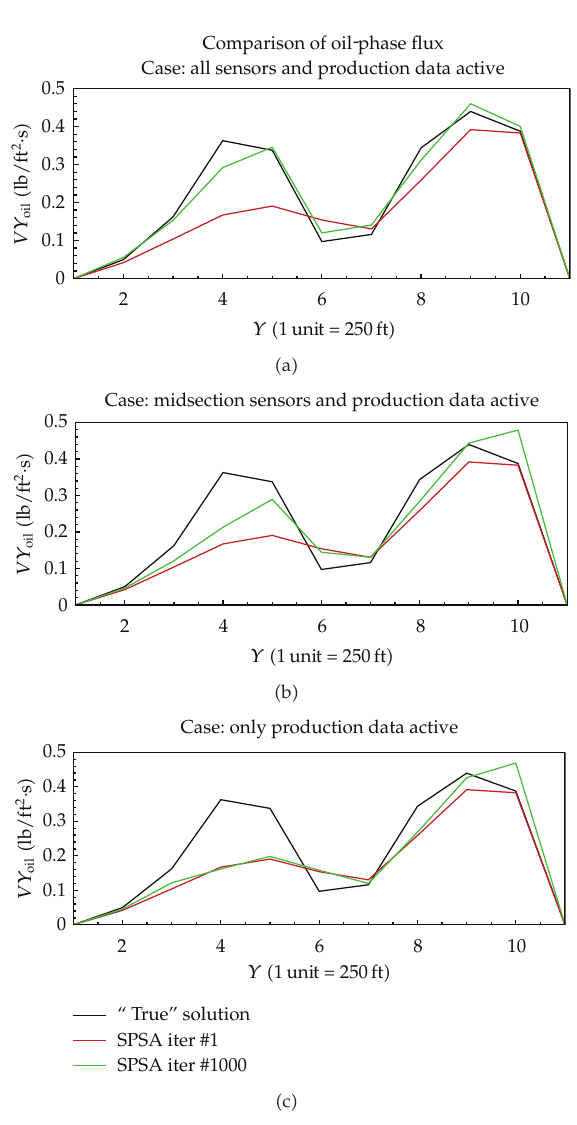
Figure 4: Example 1: history matching of oil phase fluxes based on sensor